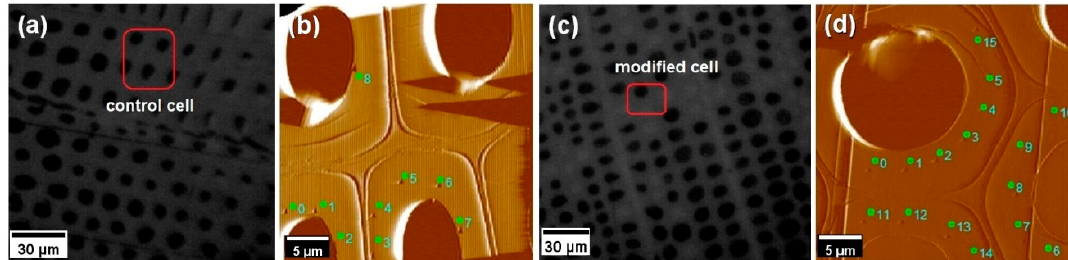
Figure 1. Microscope images showing the positioning of indents: ( a ) and ( c ) optical micrograph of the transverse section of wood samples; ( b ) and ( d ) scanning probe microscopy (SPM) images of wood cell walls after nanoindentation (NI).